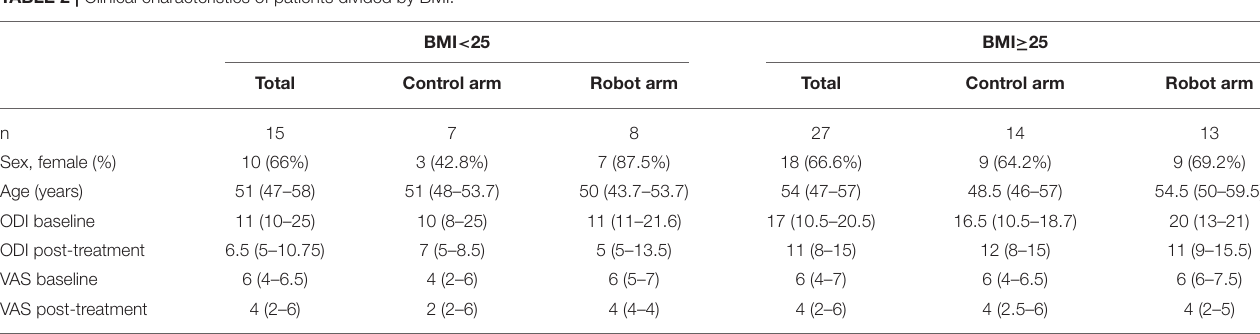
TABLE 2 | Clinical characteristics of patients divided by BMI.